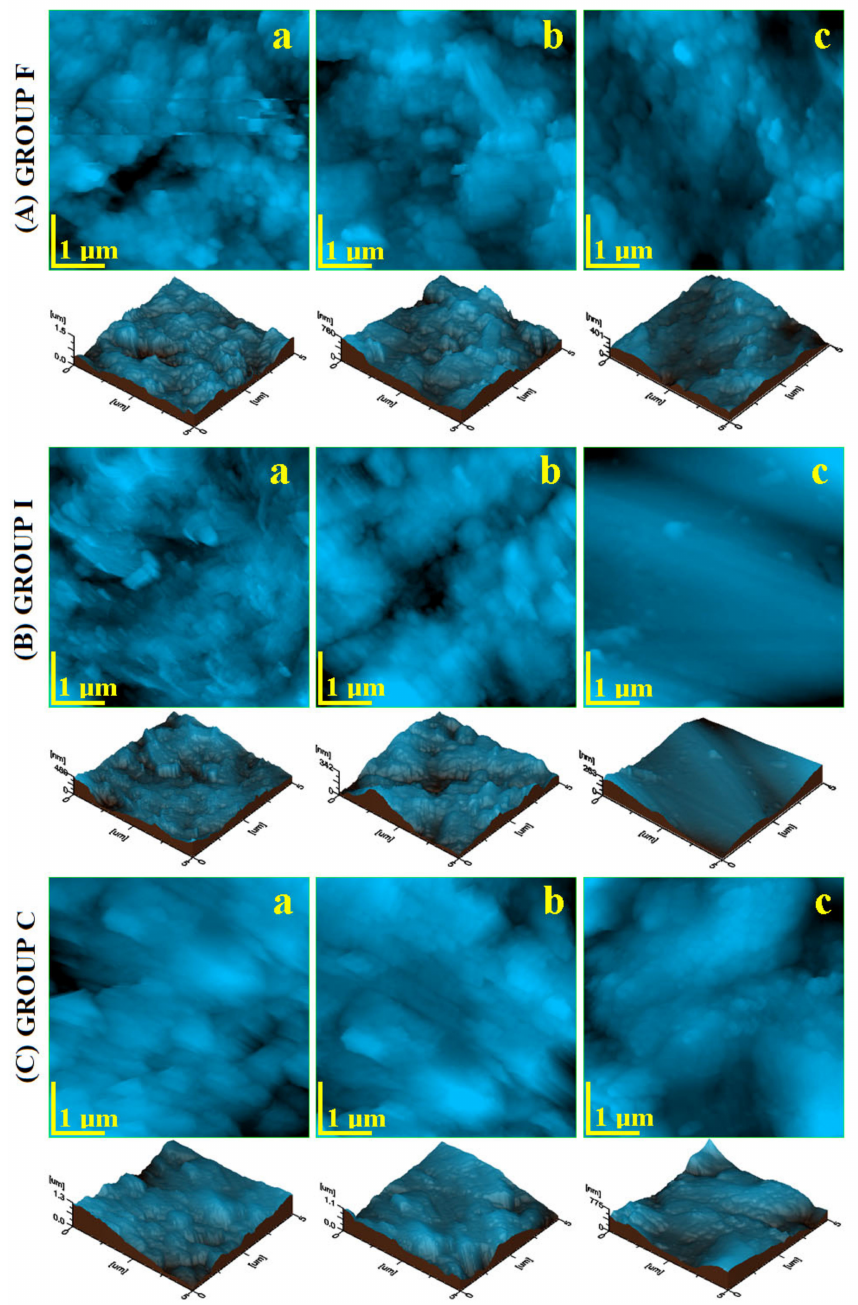
Figure 2. AFM topographic images of the fine microstructure without treatment ( a ), after flu- orination ( b ), and after photodynamic laser fluorination ( c ), for the investigated samples. The tridimensional profile is given below each topographic